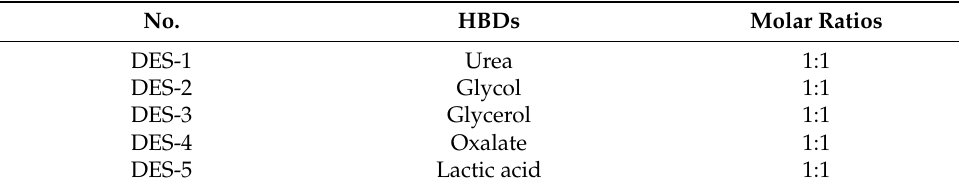
Table 2. The details of the prepared DESs (HBA: choline